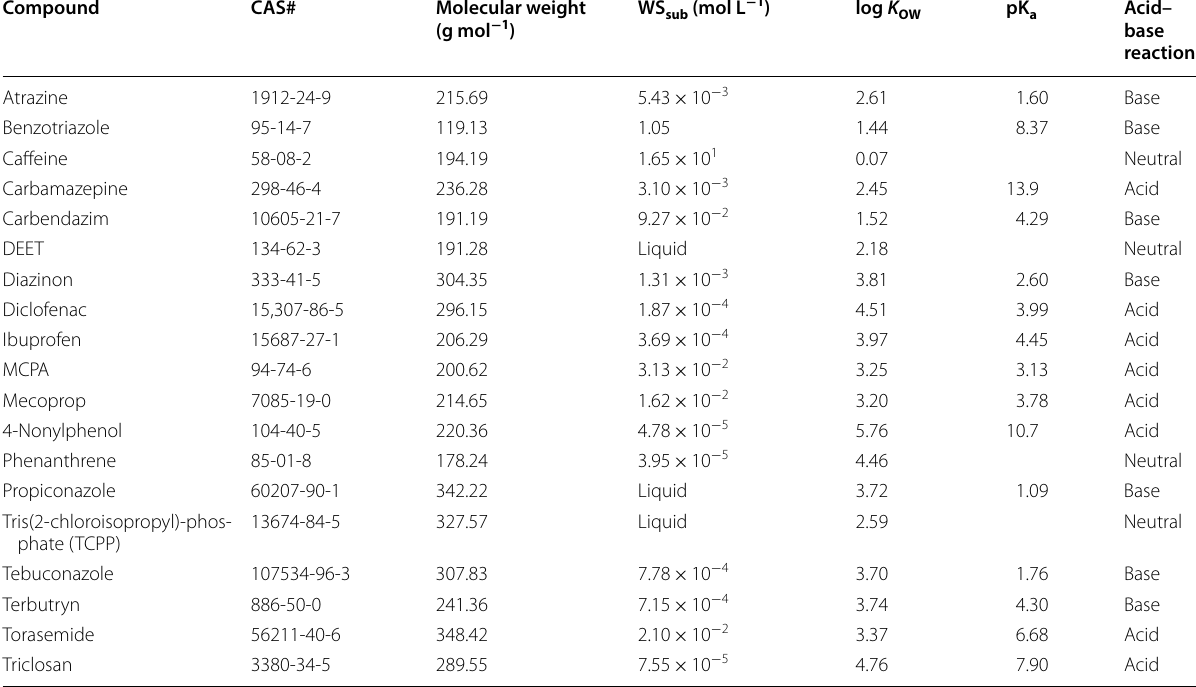
Properties are either taken from EPISuite (molecular weight and log K OW of neutral species) or the PubChem database (pK a ). Subcooled liquid solubilities (WS) were estimated based on melting points according to Kan and Tomson [18] and Liu et al. [24]